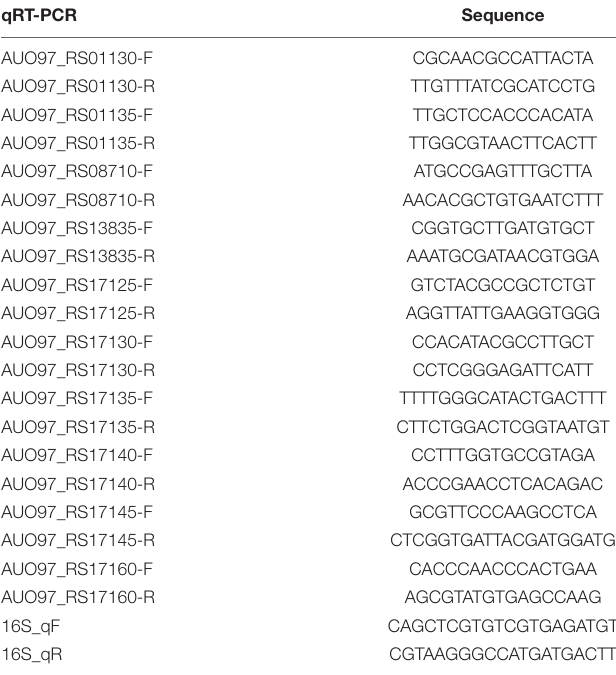
TABLE 3 | Real-time quantitative PCR